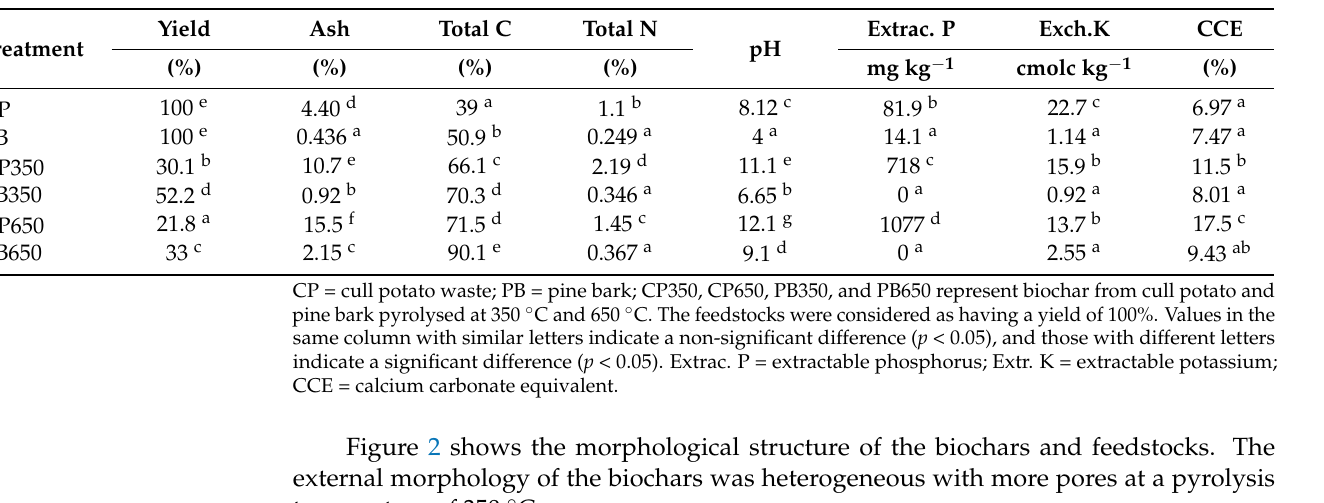
Table 2. Selected characteristics and calcium carbonate equivalents of feedstocks and